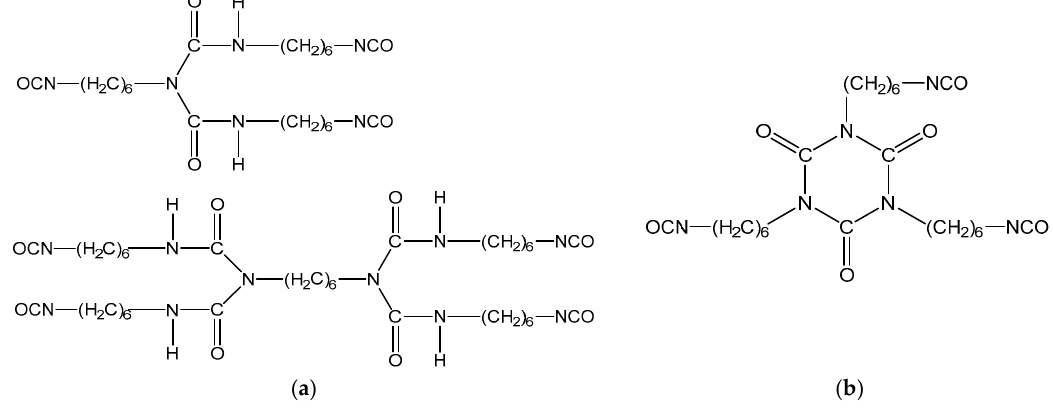
Figure 1. Chemical structure of ( a ) HDI-biuret and ( b ) HDI-trimer.